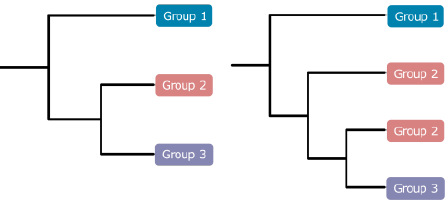
Figure 3. Two different tree topologies across all analyses. Group 1 represents the Azeliinae, Muscinae, and Stomoxyinae. Group 2 represents Atherigoninae and Reinwardtiinae. Group 3 represents Mydaeinae, Phaoniinae, and Coenosiinae.